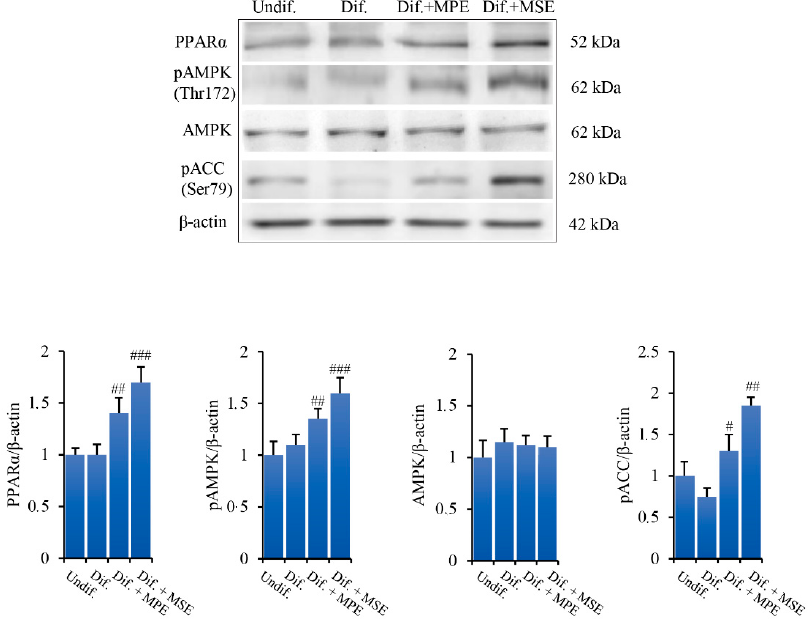
Figure 5. MPE and MSE up-regulate PPAR α and activate AMPK in 3T3-L1 adipocytes. 3T3-L1 cells were treated with pro-differentiative agents for 8 days in the presence or absence of 100 µ g/mL MPE or MSE, as reported in Methods. Then, cell lysates were analysed by Western blotting using specific primary antibodies directed against PPAR α , AMPK, phospho-AMPK and phospho-ACC. Equal loading of proteins was verified by immunoblotting for β -actin and showed values were assigned in relation to undifferentiated 3T3-L1 cells (Undif). The bar graphs represent the mean of three independent experiments ± SD. # p < 0.05, ## p < 0.01 and ### p < 0.001 with respect to differentiated untreated cells (Dif.).